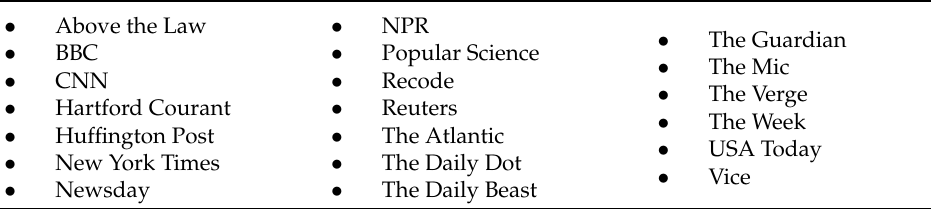
Table 1. News organizations included in comment removal